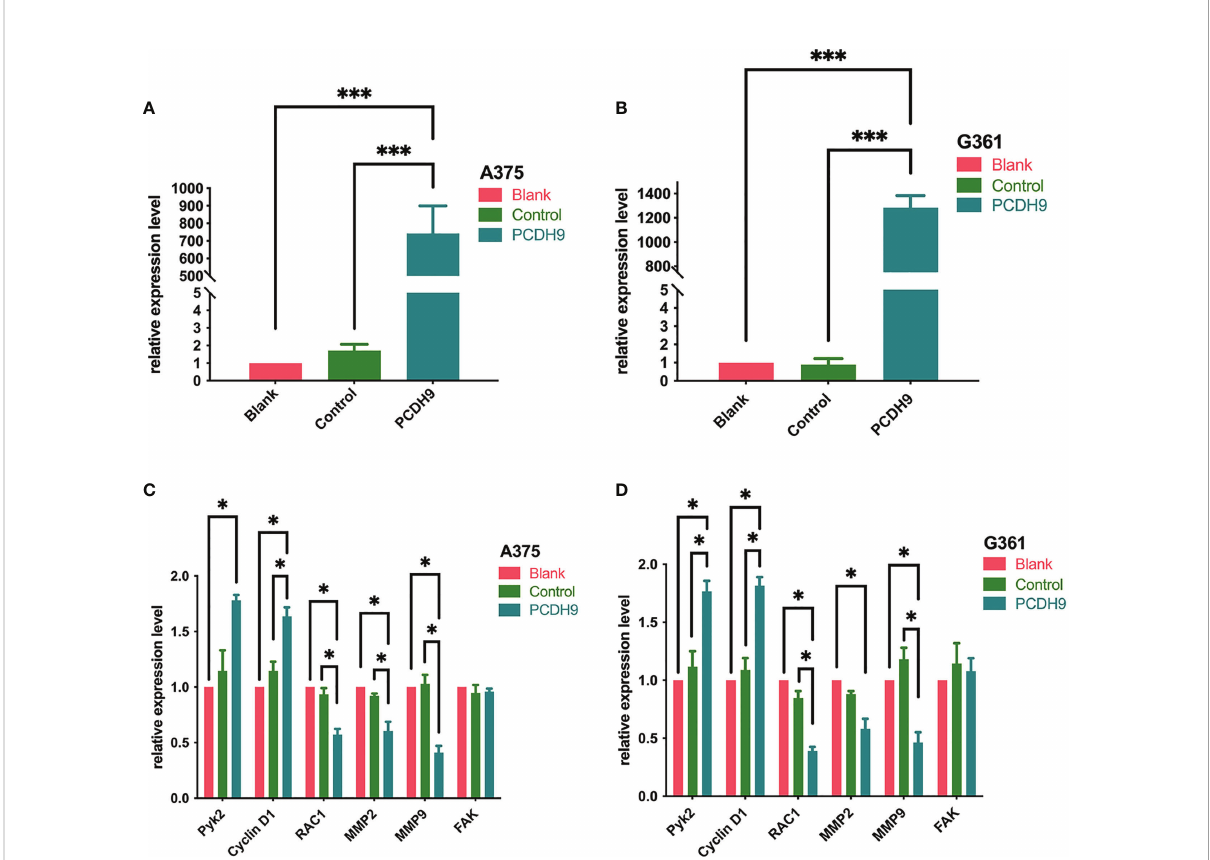
FIGURE 1 Effects of PCDH9 overexpression in melanoma cells measured by qRT-PCR. The expressions of PCDH9 were signi fi cantly upregulated by lentivirus infection (A, B) . Overexpressed PCDH9 signi fi cantly upregulated the gene expressions of Pyk2 and Cyclin D1 and downregulated RAC1, MMP2, and MMP9 except for FAK in A375 (C) and G361 (D) cells. * p < 0.05 and *** p < 0.001 compared groups using one-way ANOVA followed by least signi fi cant difference post-hoc tests. The results cited from the preprint doi: